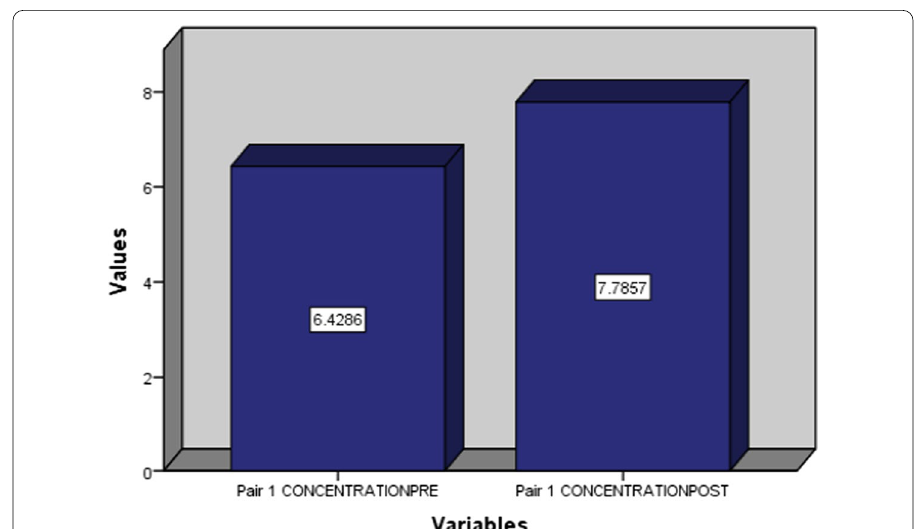
Fig. 6 Paired samples statistics: concentration Source: SPSS 23.0 output